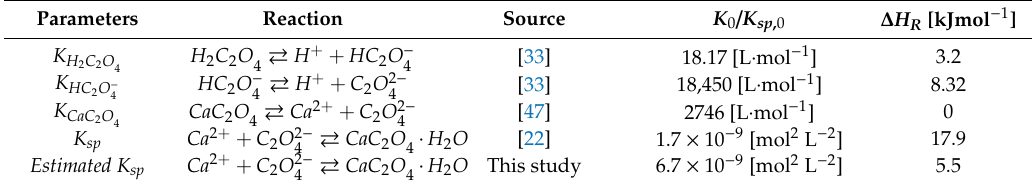
Table 3. Associations constants K 0 , solubility products of COM, and enthalpy of reaction of the given reactions from literate and the estimated values of K sp ,0 and ∆ H R of COM in this study. Estimated values are calculated using the temperature dependent solubility data of COM in ultrapure water given in Figure 4 using the proposed